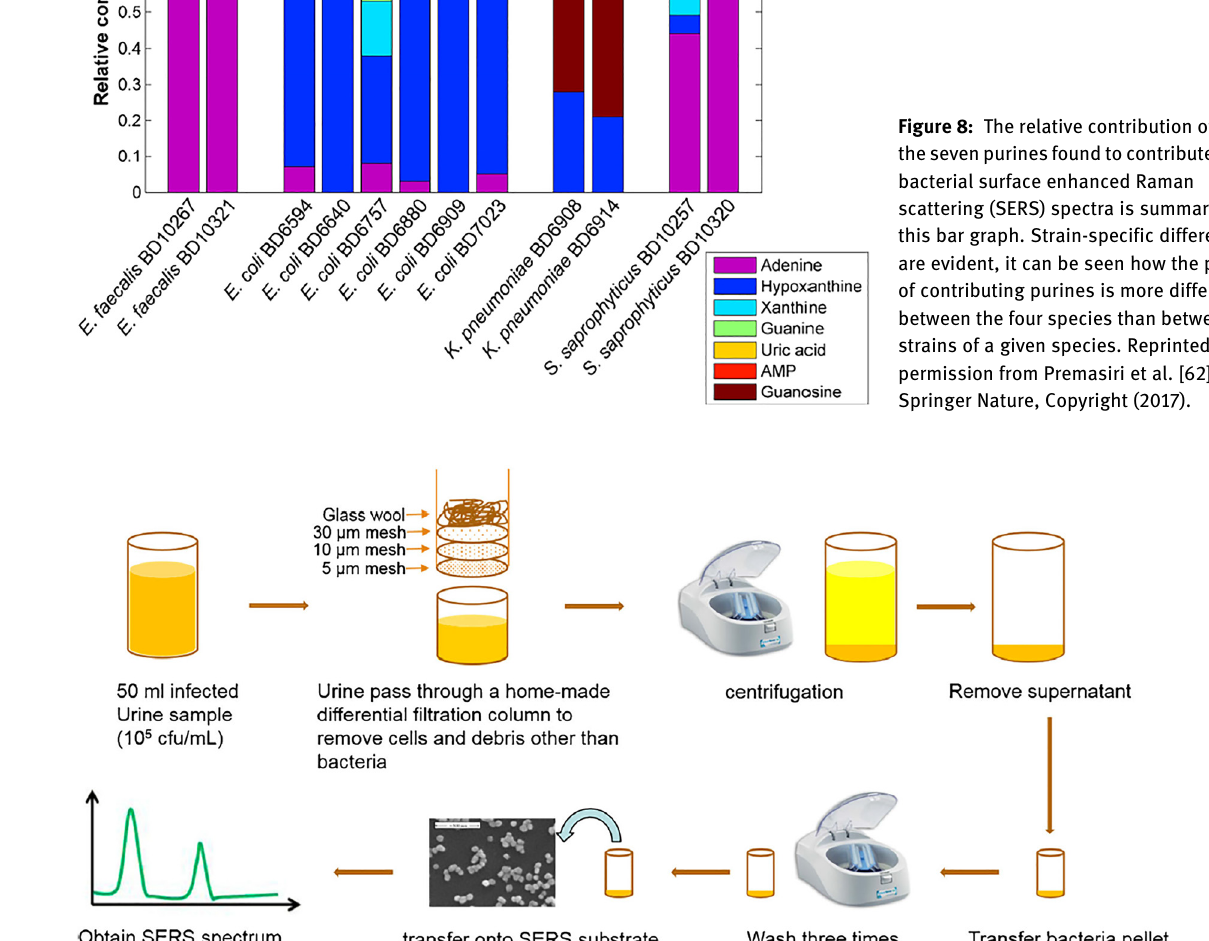
on membrane fi lter, (2) washing, (3) incubation, and (4) detection. First, the bacterial solution was injected into the fi ltration zone at 2 mL/min and bacteria were trapped on the membrane fi lter. An amount of 1.5 mL of deionized water was then injected to the chamber to force the culture medium to pass through the fi lter. The trapped bacteria then released metabolites in the chamber fi lled with deionized water for 20 min (incubation at room tempera- ture). Consequently, only the metabolite solution in the